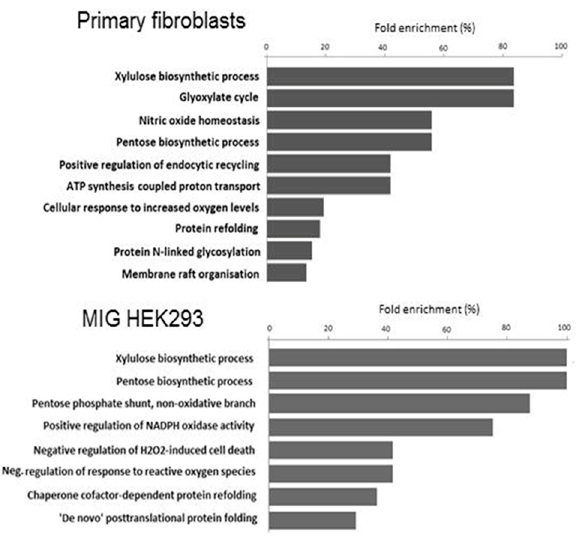
Figure 8. Comparative Gene Ontology Term Enrichment (GOTE) analyses of increased, fold-changed proteins in response to galactose in the MIG (metabolic induction of glactosemia) HEK293 cell model and in the galactosemic fibroblast model.